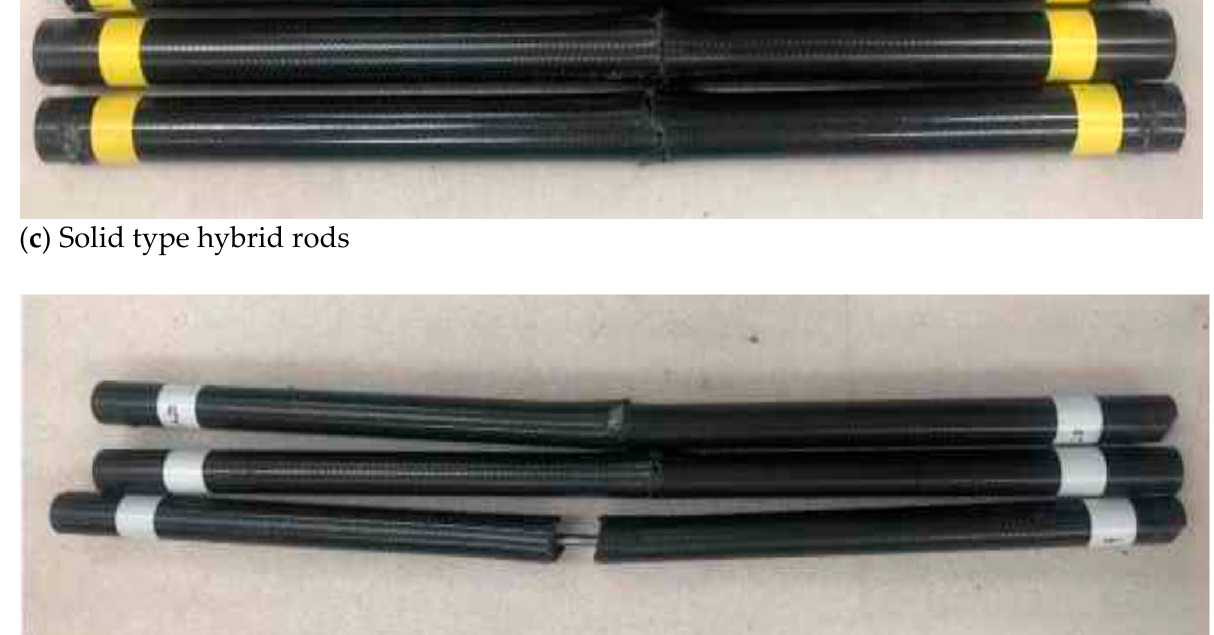
Figure 9. Numerical model built using ABAQUS. 2.3. Test Samples To determine the buckling strength of the rod, 16 specimens were prepared. They were categorized as Solid type hybrid rod and hollow type hybrid rod depending on the percentage of CFRP material combined with steel to form a single rod. For each category, there were 2 specimens for testing. The length of each rod was 650 mm and outer diameter